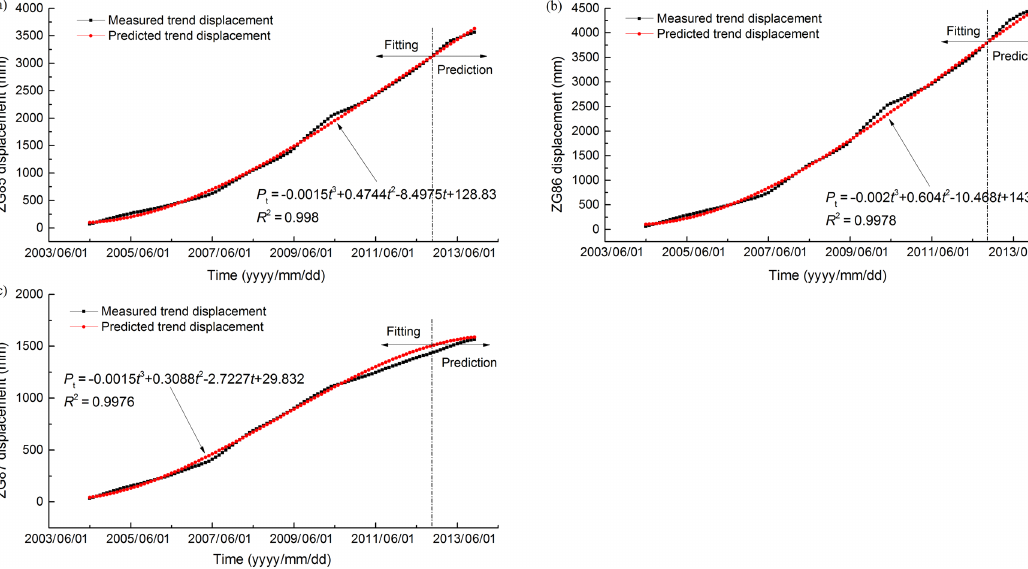
Figure 9. Measured and predicted trend component displacement of Shuping